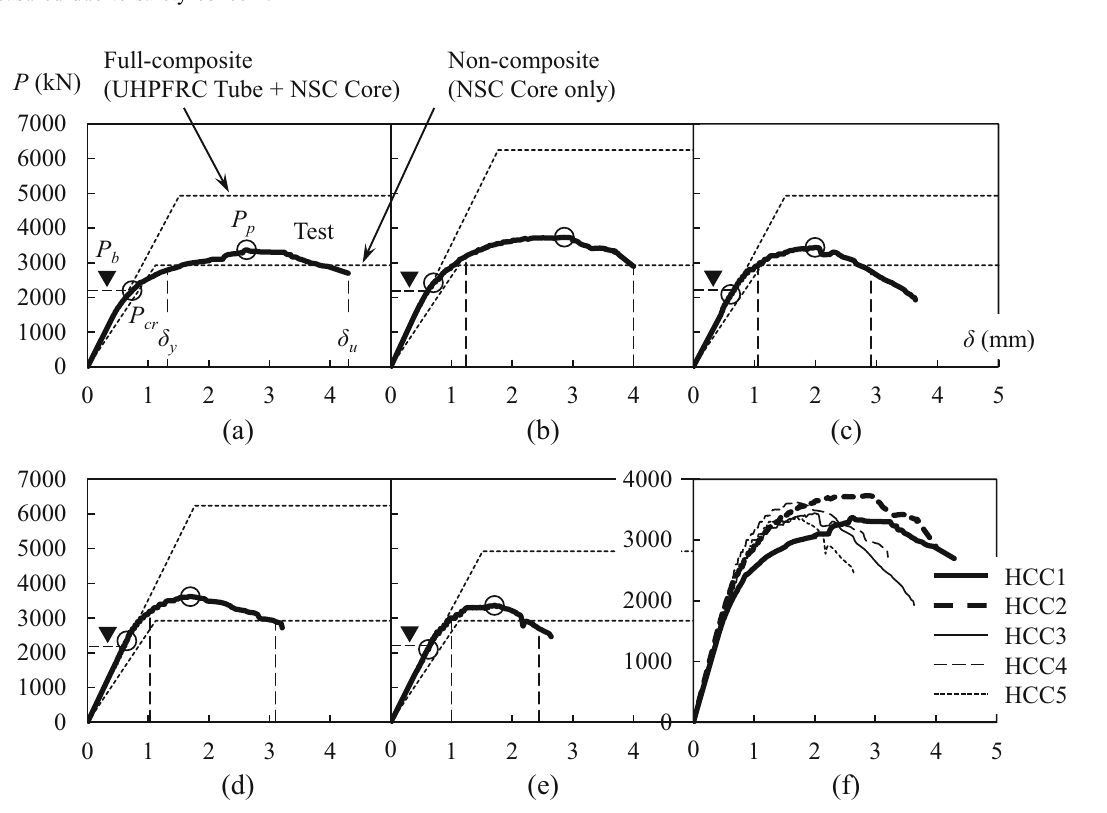
Fig. 7 Axial load–displacement relationship of column specimens: a HCC1 (control), b HCC2 ( V f = 2.0%), c HCC3 ( s = 200 mm), d HCC4 ( V f = 2.0%, s = 200 mm), e HCC5 (no wire-mesh), f comparison.